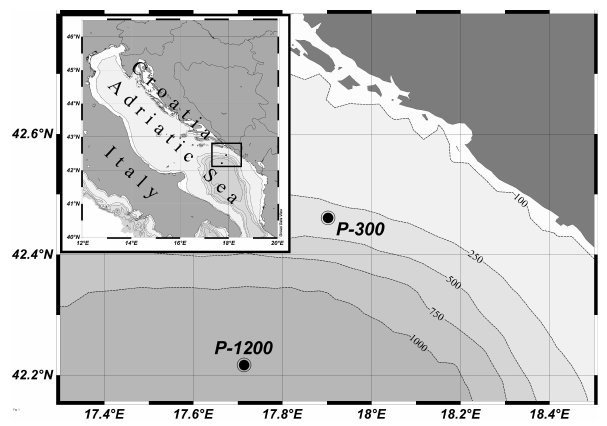
Figure 1. Sampling stations in the Southern